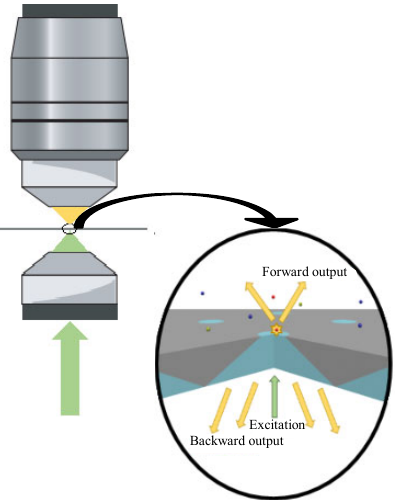
Fig. 2 Scheme for experimental setup for analysis using NFS (this scheme uses forward scattered fluorescent signal for observation).